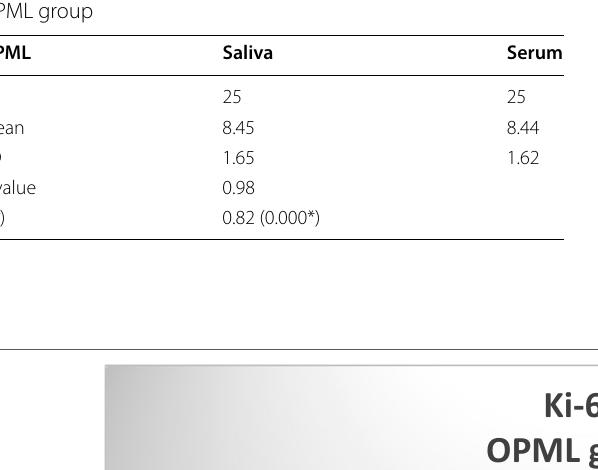
Table 4 Mean and standard deviation of saliva and serum in